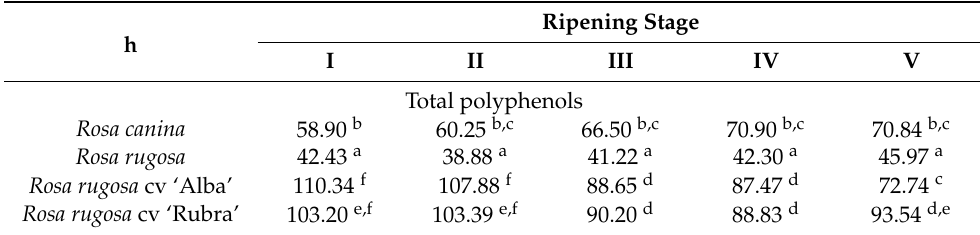
Table 3. Effects of ripening stage on the amounts of total polyphenols in the rosehip fruits, mg 100 g − 1 DW. Ripening Stage h I II III